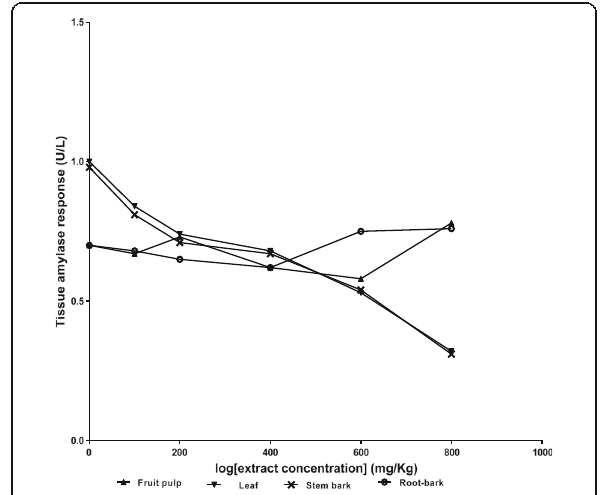
Fig. 2 Dose-response line plot of the influence of Annona muricata methanolic extract on tissue amylase activity